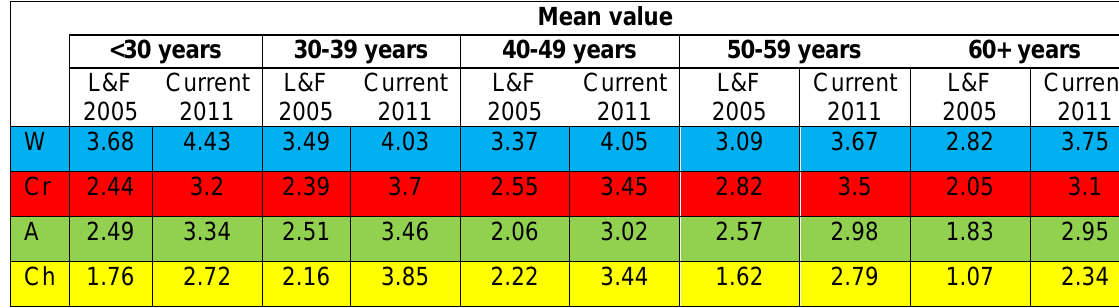
Table 4 Comparison of work-life benefit preferences for different age cohorts (after Lingard and Francis